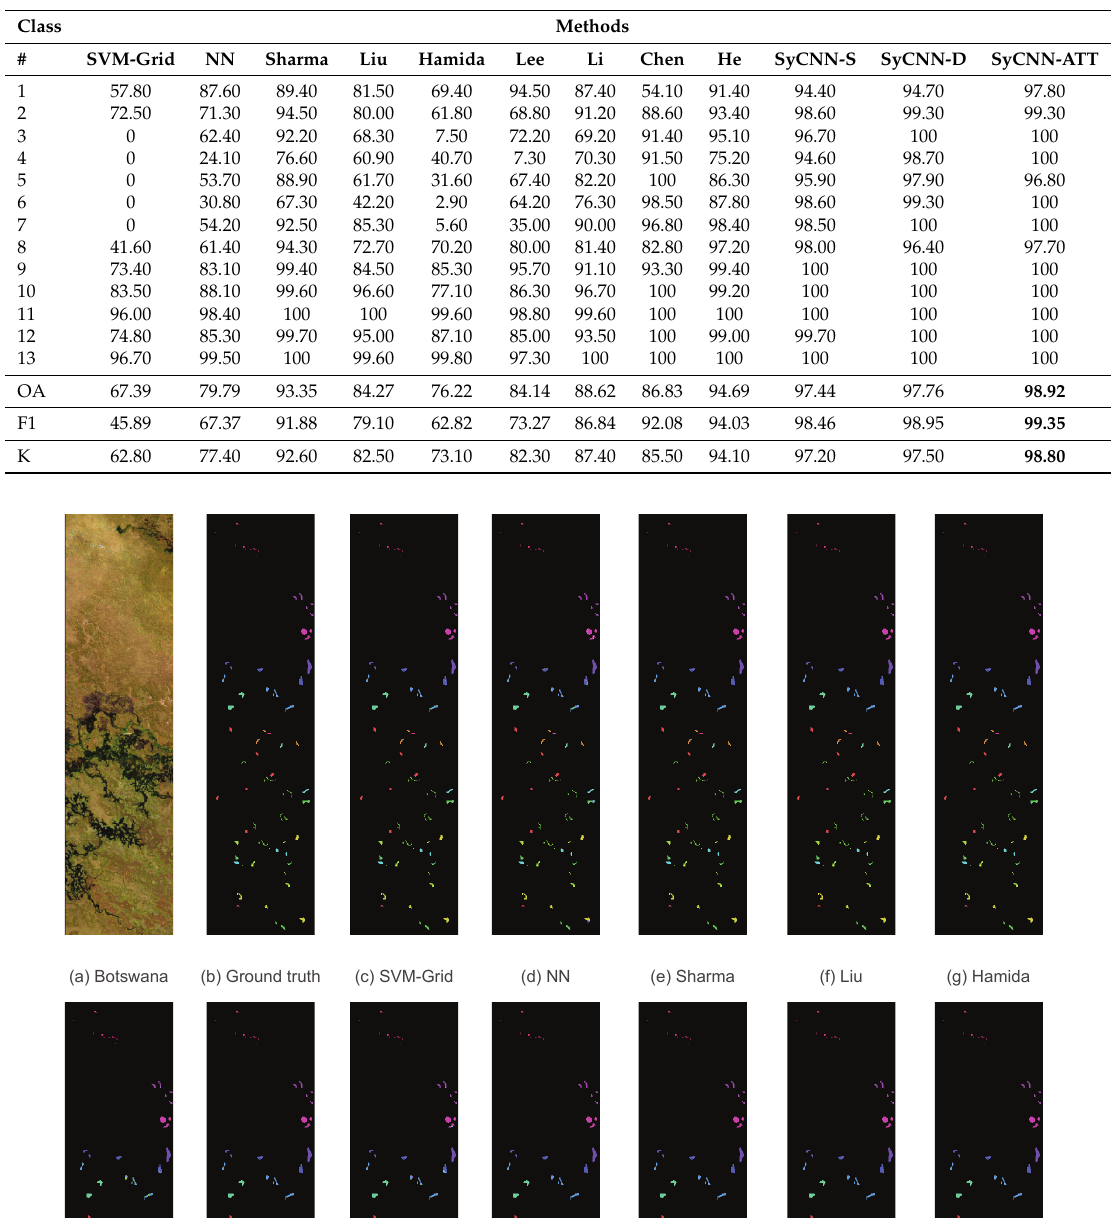
Table 6. Classification results of the Salinas scene.